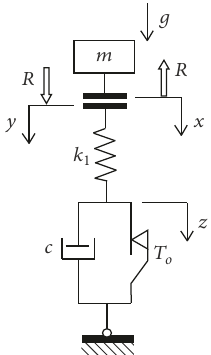
Figure 3: Visualization of elastic-viscoplastic system.